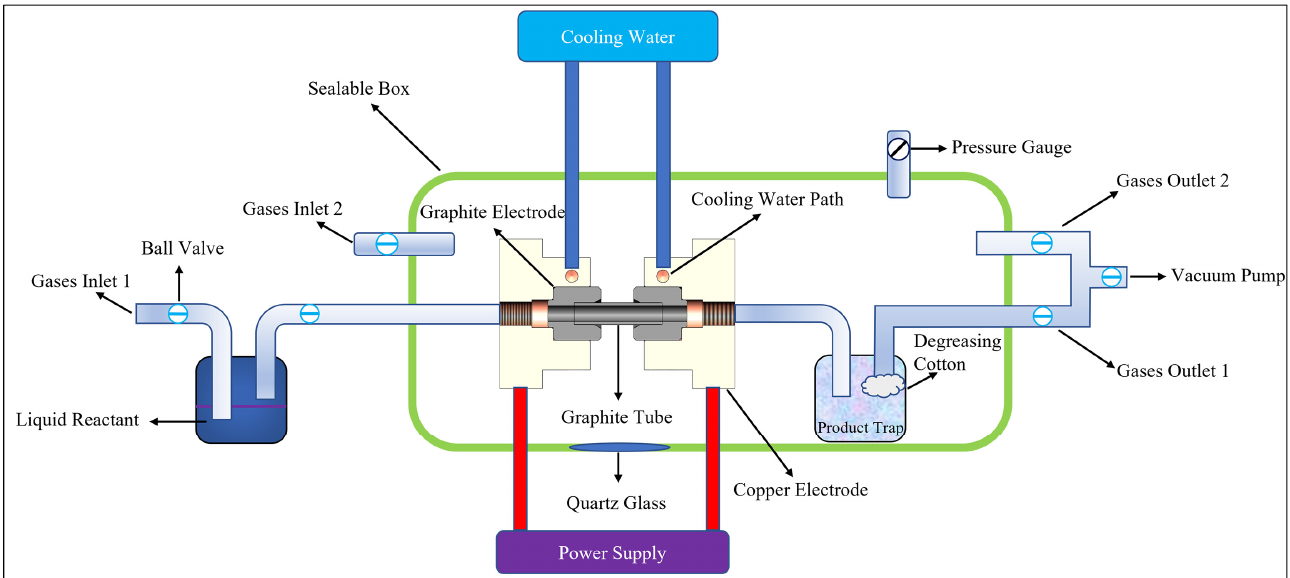
Figure 1. Schematic of the newly developed ultrahigh-temperature flash vacuum pyrolysis (UT-FVP) apparatus.